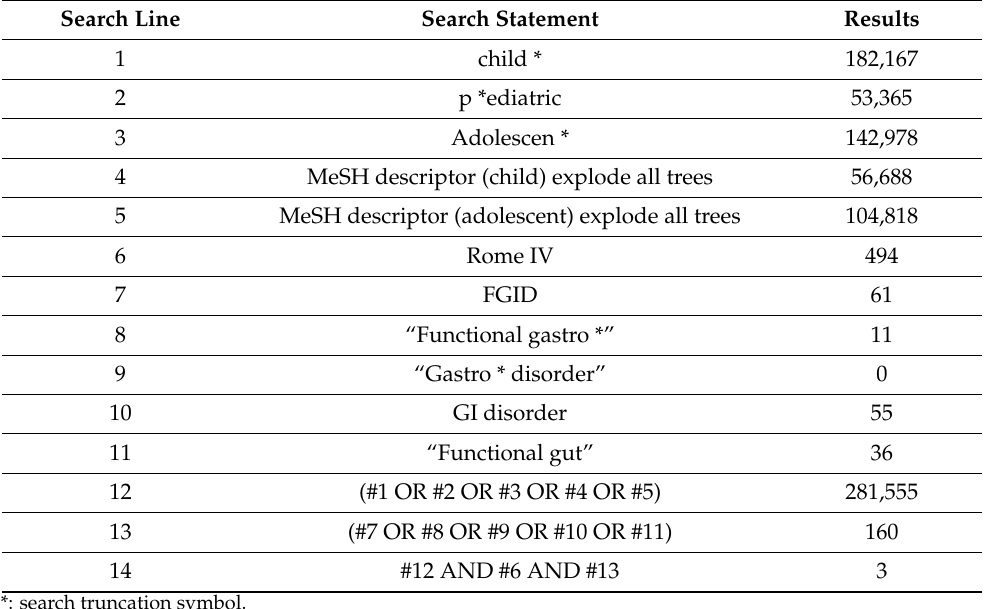
Table A8. Cochrane (Cochrane library publication date from January 2016 to March 2021).